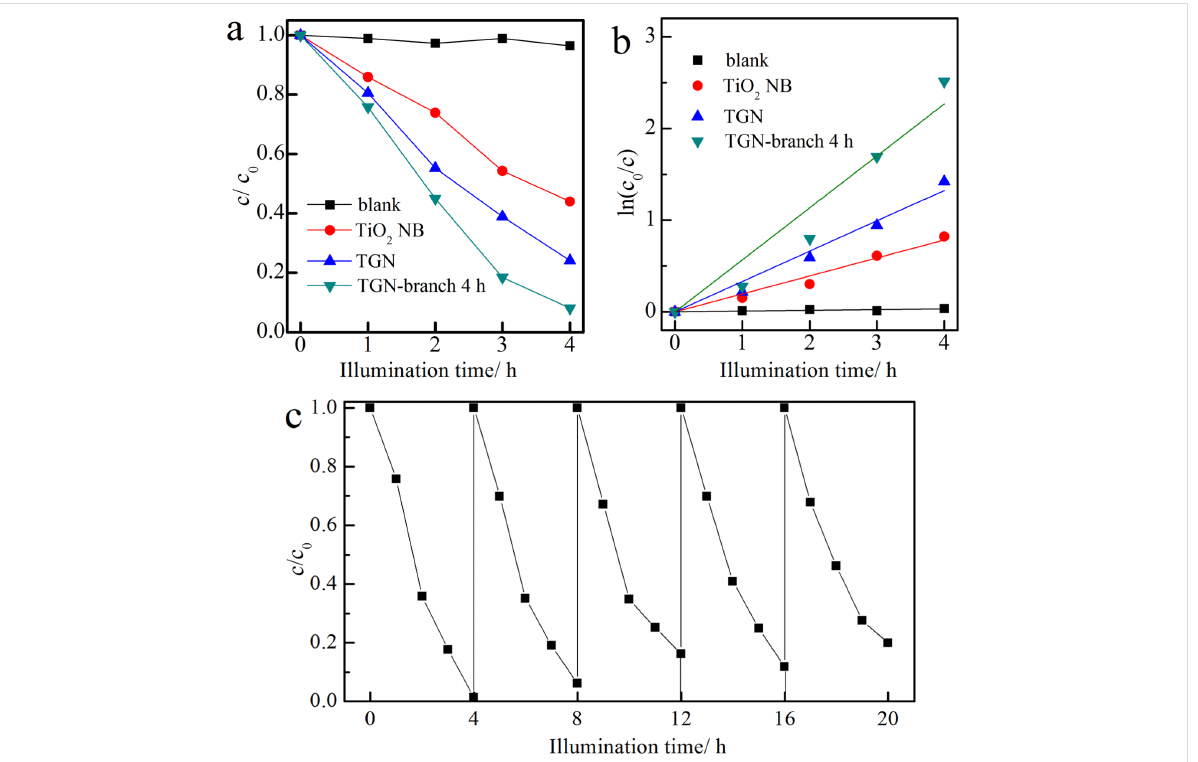
Figure 7: Photodegradation of phenol in the presence of TiO 2 nanobelts (TiO 2 NB), TGN and TGN-branch 4 h under UV light illumination: (a) the deg- radation curves; (b) the fitting results assuming a pseudo-first order reaction; and (c) the cycling performance of TGN-branch 4 h